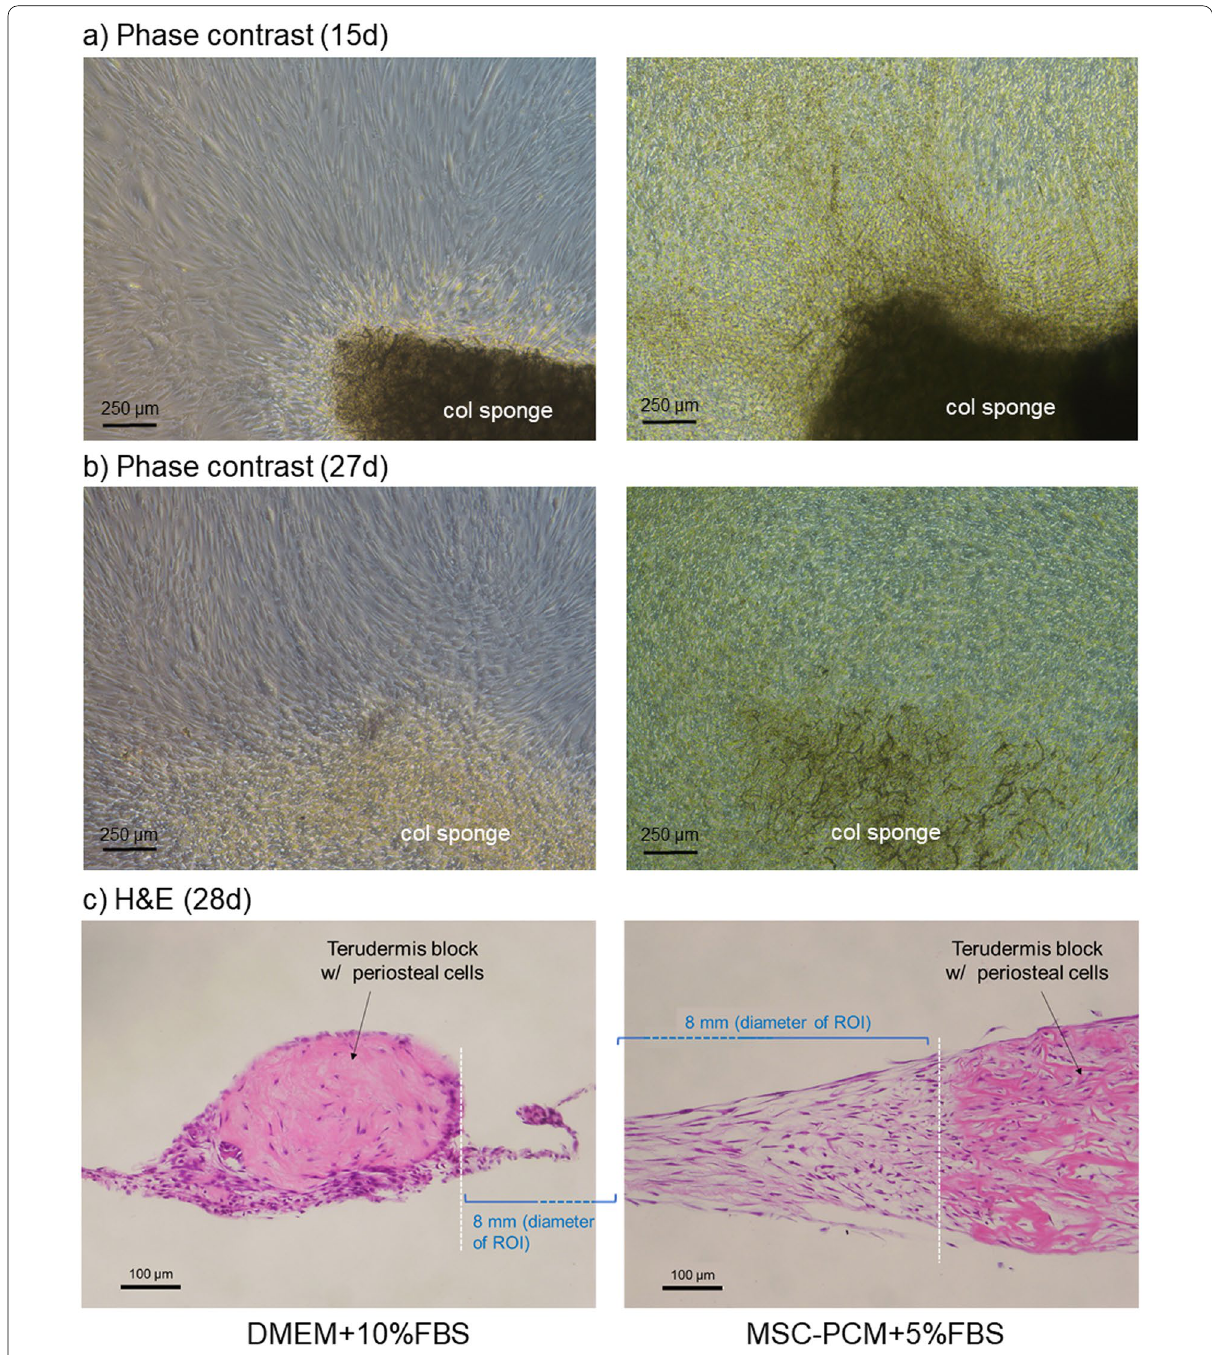
Fig. 4 Photomicrographic observations of cell layers formed by cell outgrowths of nearby pieces of a collagen (col) sponge. a , b Phase-contrast microscopic observations. c H&E staining of sagittal sections. The region of interest for the determination of absorbance is indicated by parentheses and blue